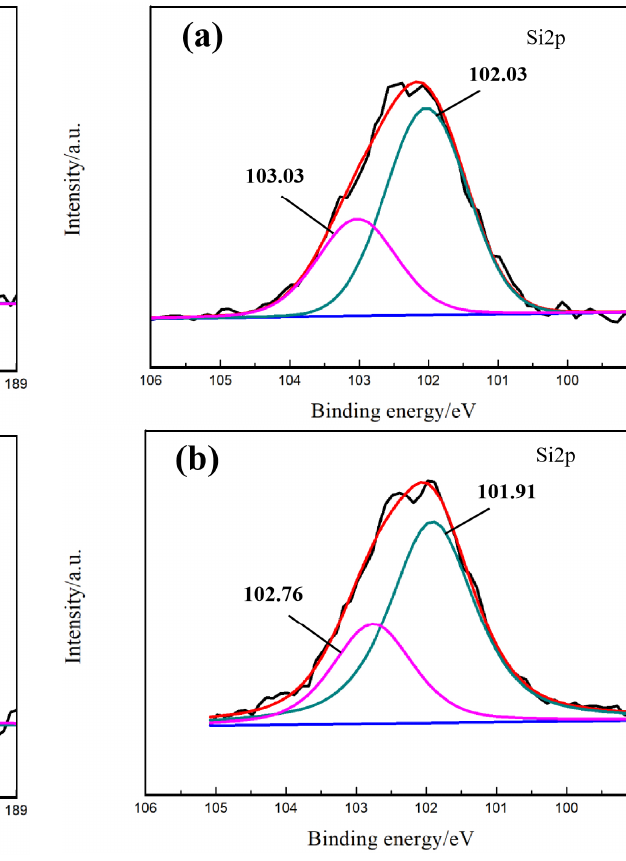
Figure 3: XPS peak differentation imitating analysis of B(1s): a) flux, b) slag Table 4: XPS analysis of flux